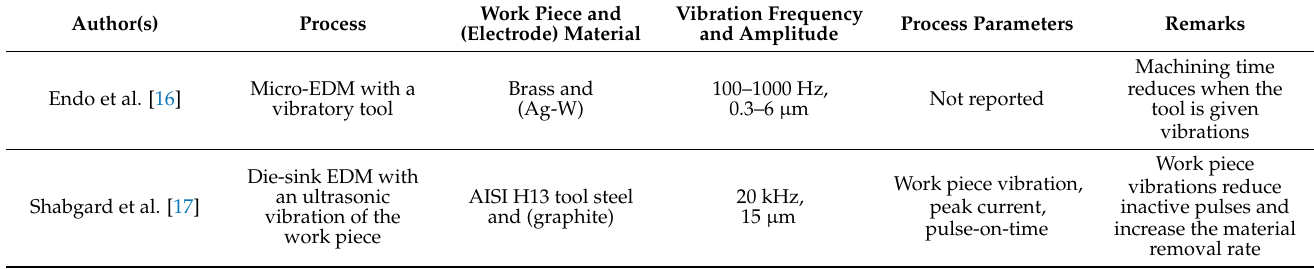
Table 1. Summary of the literature reporting vibration-assisted EDM